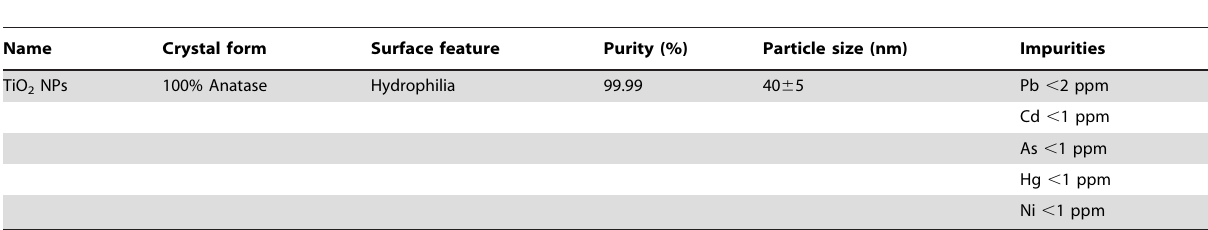
Table 1. Characteristics of TiO 2 NPs used in this